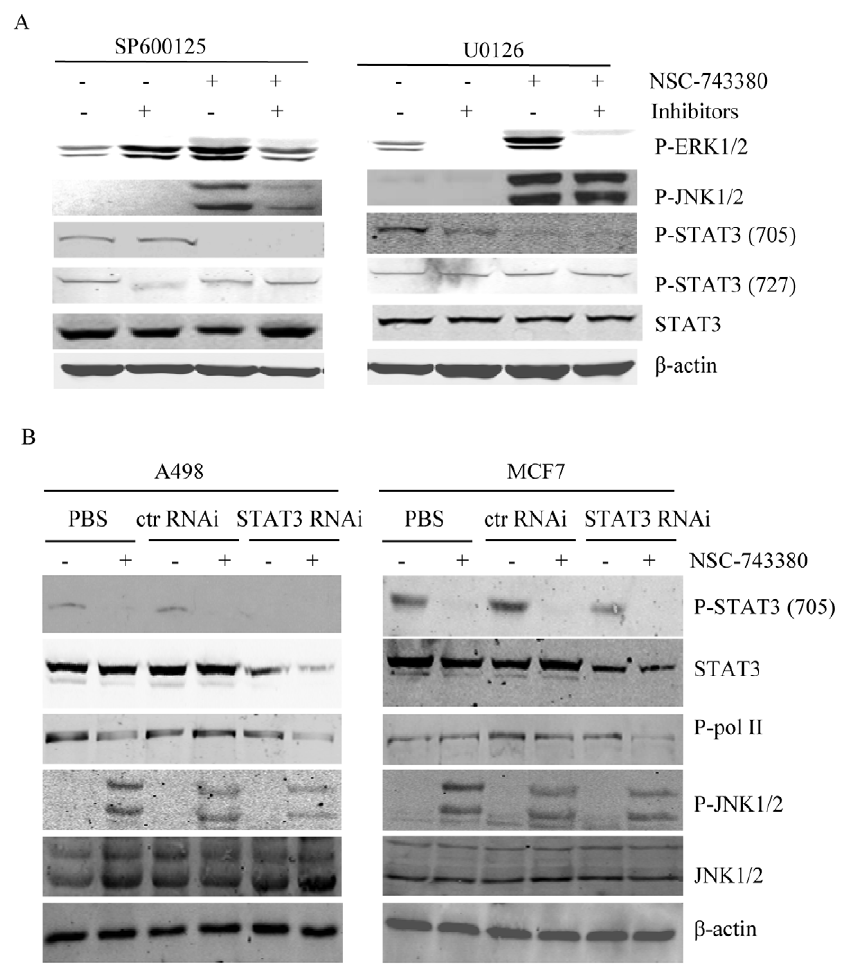
Figure 5. Independent effects on JNK, STAT3 and RNA polymerase II induced by NSC-743380. A) Effect of JNK and ERK inhibitors. MCF-7 cells were treated 1 m M NSC-743380 in the presence or absence of 10 m M SP600125 or 10 m M U0126 and examined for expression of p-ERK, p-JNK, and p-STAT3 (Tyr705 and Ser727). Whole-cell lysates were subjected to Western blot analysis, and b -actin was used as the loading control. B) Effect of STAT3 knockdown. After transfected with control RNAi or STAT3 RNAi for 48 hours, A498 and MCF7 were treated with 1 m M NSC-743380 for 6 hours. Phosphorylation of JNK, STAT3 and PloII were determined by Western Blot analysis. b -actin was used as the loading control.